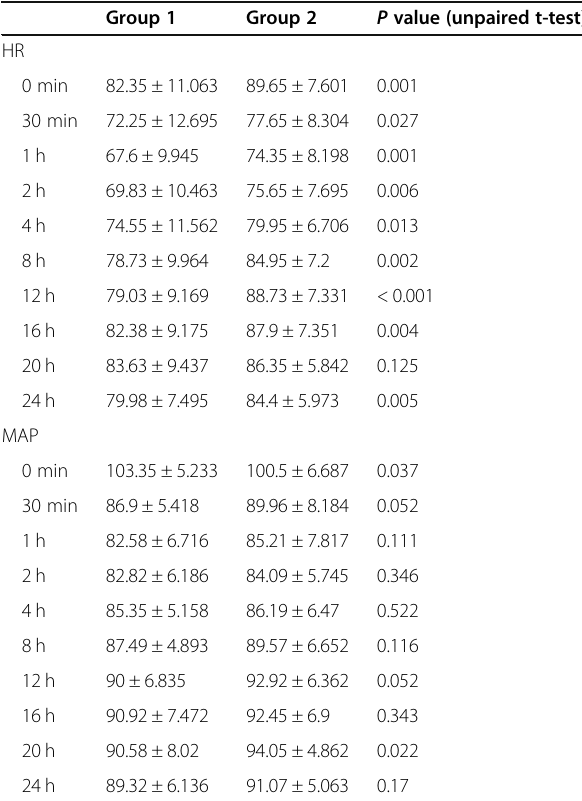
Table 4 Comparison of heart rate and mean arterial pressure in both